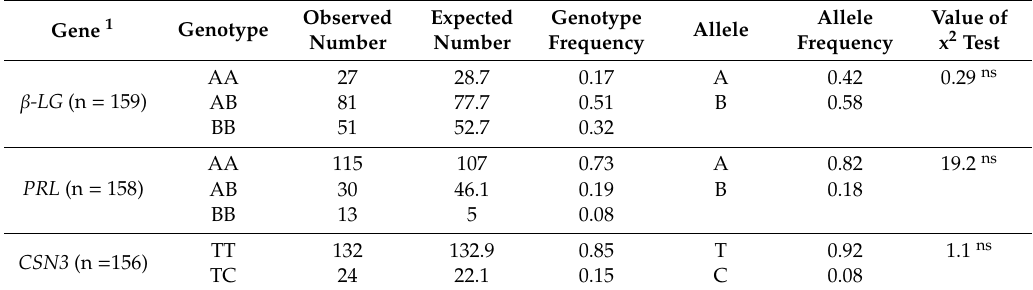
Table 3. Allelic and genotypic frequencies for β -LG, PRL , and CSN3 genes in Awassi